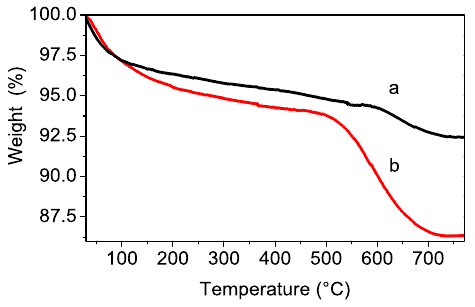
Figure 3. TGA of hydrolyzed ( a ) and pristine ( b ) powders.